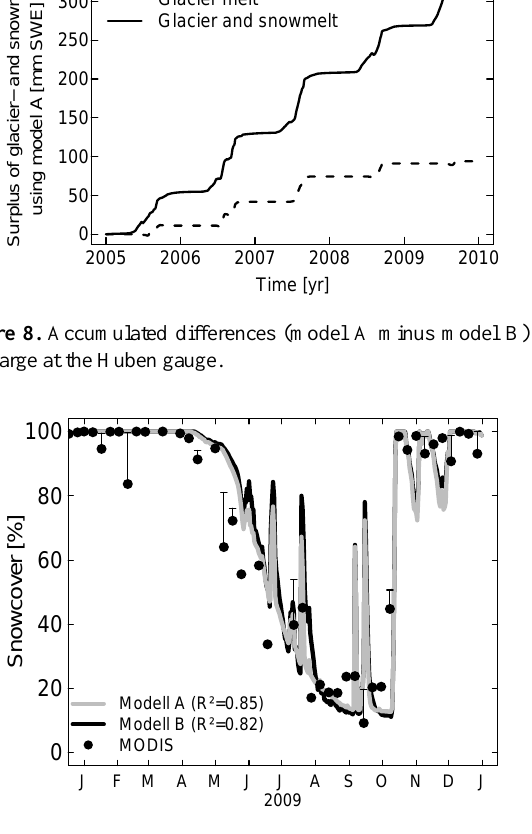
Figure 9. Snow cover in 2009 modelled by both models A and B compared with MODIS data. Error bars refer to uncertainties due to cloud